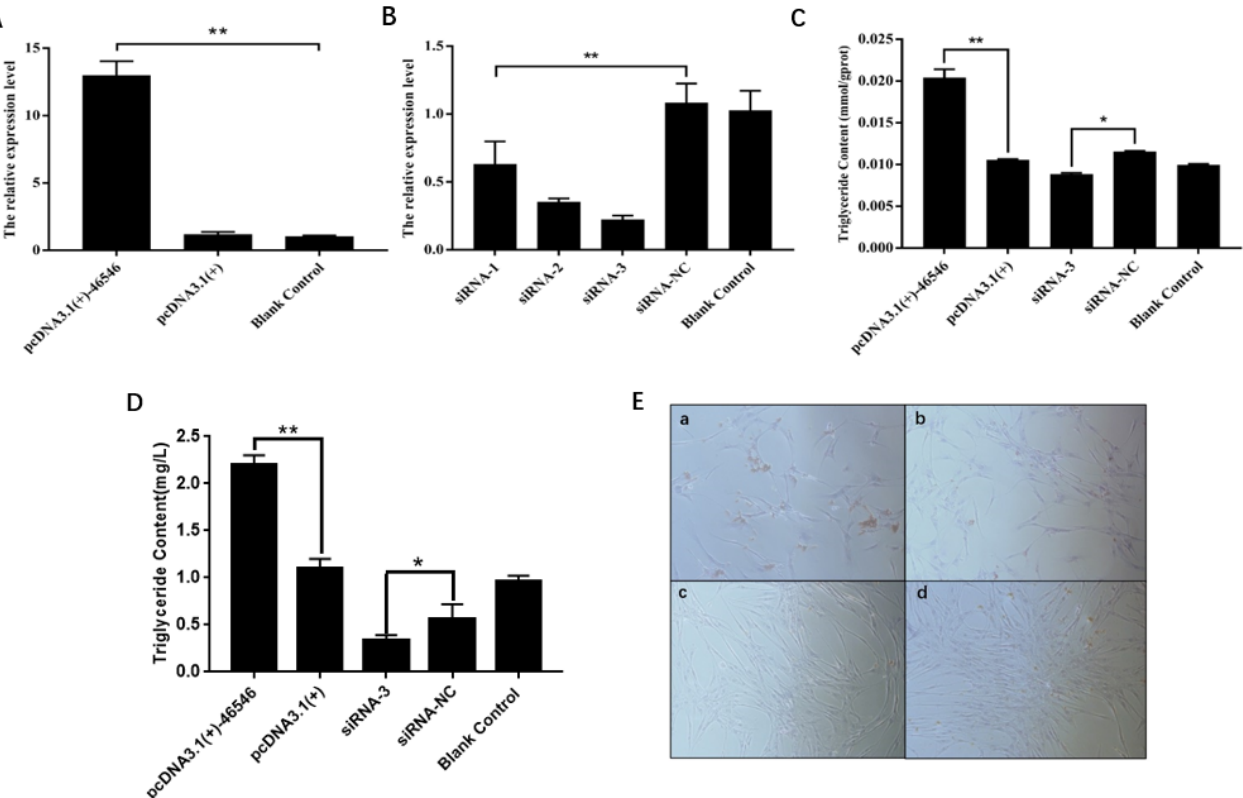
Figure 6. lncRNA-46546 promotes lipid deposition and TG synthesis in ICP2 cells. (A) pcDNA3.1(+)-46546 significantly increased the expression of lncRNA-46546 in ICP2 cells. (B) The expression of lncRNA-46546 was lowest after the transfection of siRNA-3. ** Denotes p<0.01. (C) lncR - NA-46546 promoted TG synthesis in ICP2 cells. ** Denotes p<0.01. * Denotes p<0.05. (D) lncRNA-46546 promoted TG synthesis in ICP2 cells cul - ture medium. ** Denotes p<0.01. * Denotes p<0.05. (E) Treatments applied to ICP2 cells: (a) pcDNA3.1(+)-46546 transfection, (b) pcDNA3.1(+) transfection, (c) siRNA-3 transfection, and (d) siRNA-NC transfection. After staining with oil red O, lipids were dyed red by oil red O, and nuclei were dyed blue by hematoxylin. Magnification, 40×. TG, triglyceride; ICP2, immortalized chicken preadipocyte